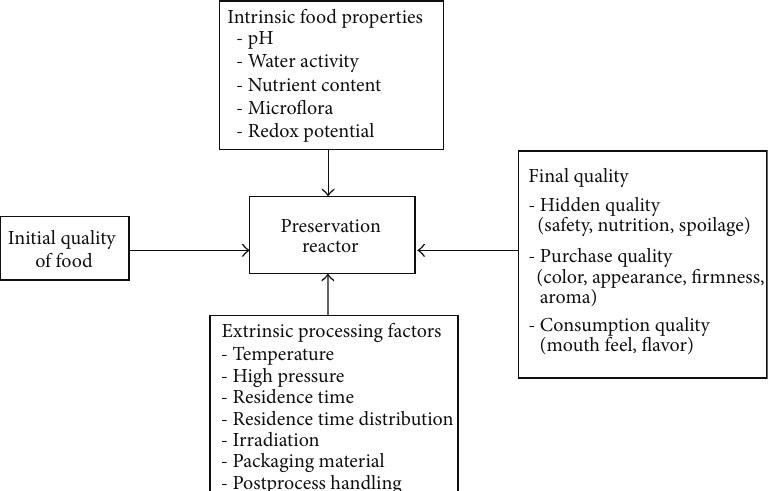
Figure 1: The preservation reactor: intrinsic and extrinsic factors that can influence the rate of deterioration of the quality of the product (adapted from